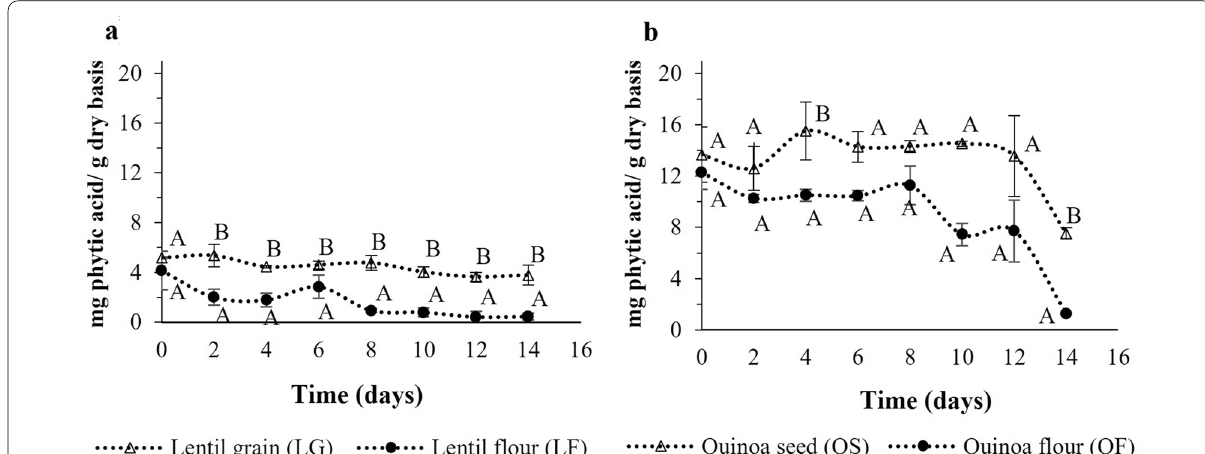
Fig. 2 Phytic acid content in lentil grain, quinoa seeds and respective flours at different fermentation times. AB Capital letters indicate significant differences between grain/seeds and flour at the 95% ( p < 0.05) significance level